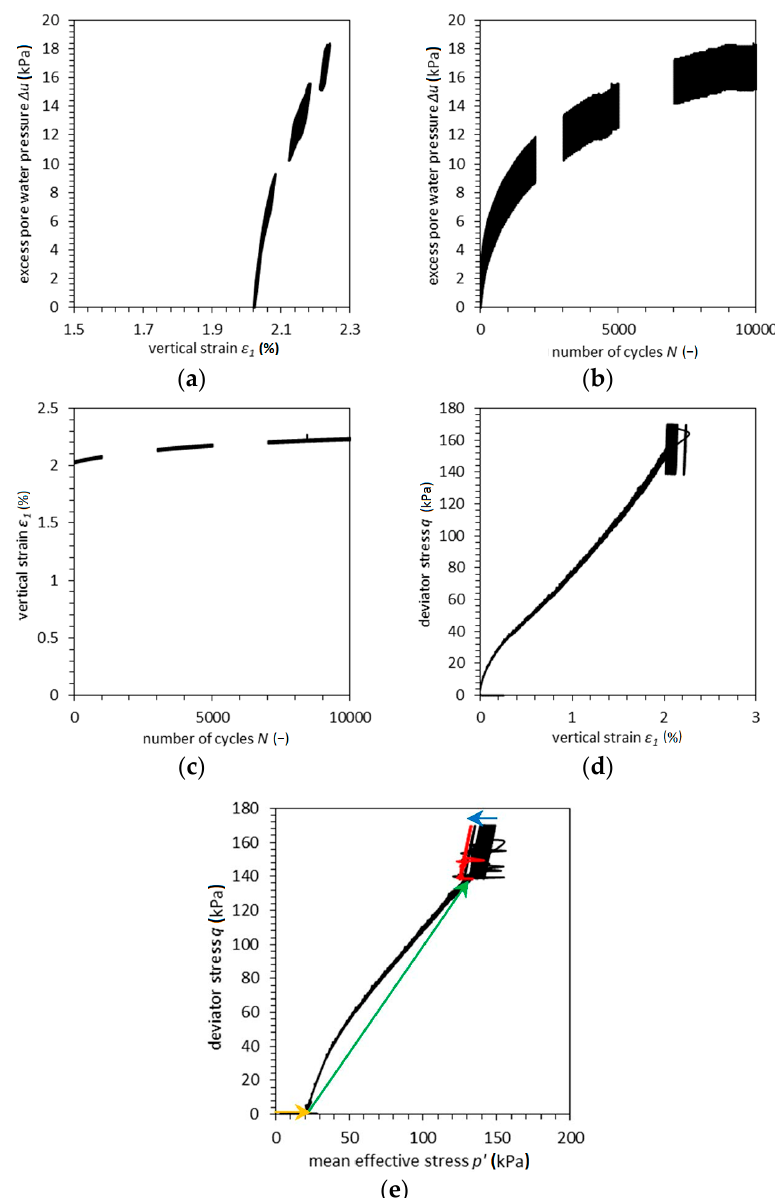
Figure 8. Results of the cyclic triaxial test for sandy silty clay under a confining pressure of 94.2 kPa and under the K 0 consolidation, initial void ratio e 0 = 0.276, K 0 = 1.07—sample 2.4: ( a ) Excess pore water pressure versus vertical strain characteristic, ( b ) excess pore water pressure characteristic versus number of cycles, ( c ) vertical strain characteristic versus number of cycles, ( d ) deviator stress–vertical strain relationship, and ( e ) the deviator stress–mean effective stress relationship (red color—last 10 cycles; arrow color—violet: Saturation phase, green: Consolidation phase, orange: First cycle of cyclic loading, blue: Cyclic loading program).